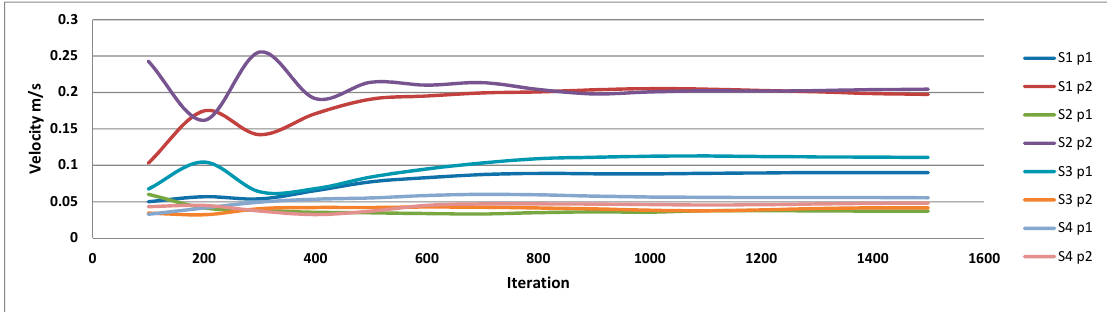
Figure 5. Liquid velocity for a 1000 L model obtained at 8 sampling points as the iterations were in progress. In this case, it can be concluded that 1500 iterations were sufficient to consider the model as stabilized.